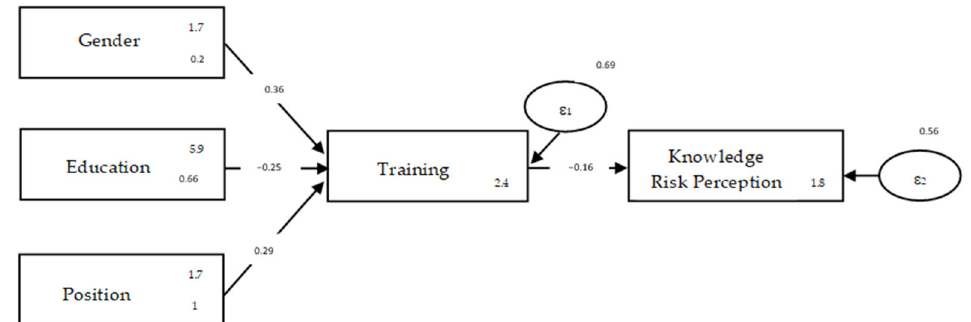
Figure 2. Structural equation model. Source: Authors’ elaboration.